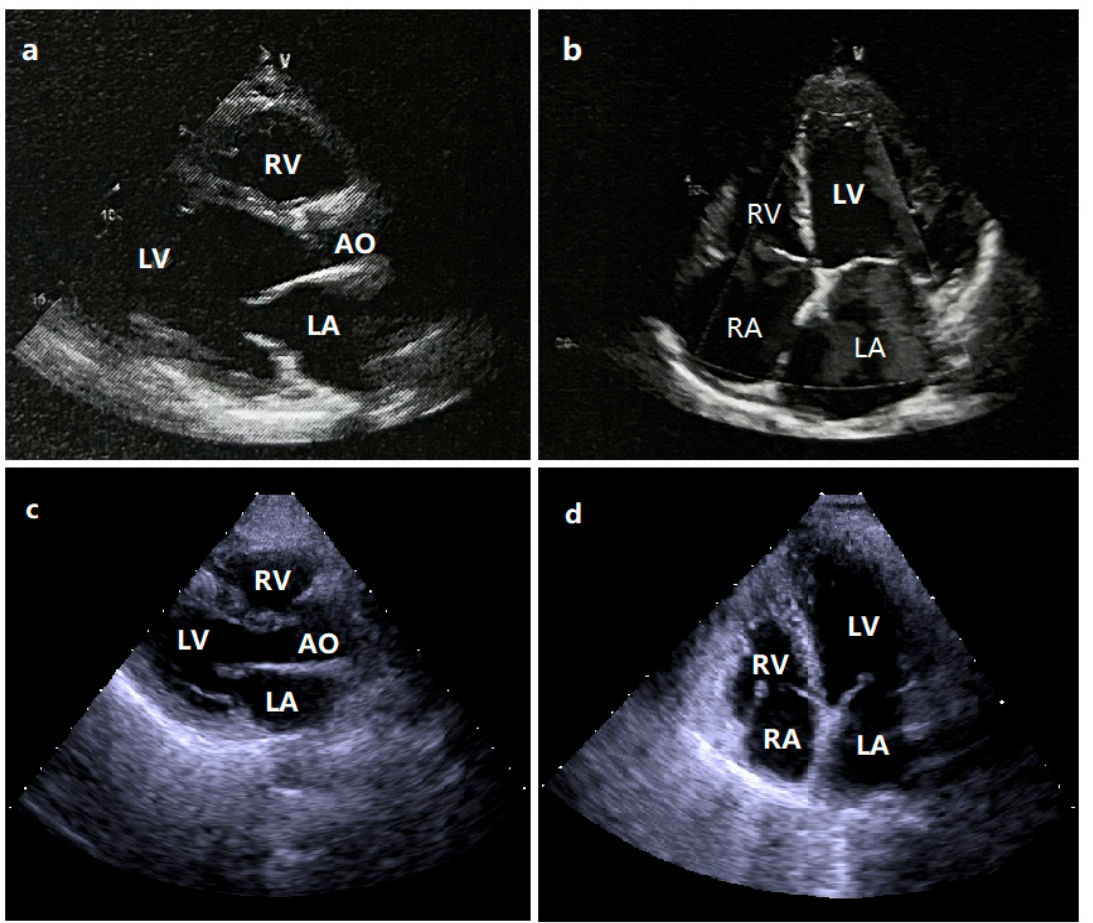
Figure 2. The representative transthoracic two-dimensional echocardiographic images from the proband affected with dilated cardiomyopathy and a healthy individual as a control: ( a ) transthoracic echocardiography findings at the left ventricular longitudinal view from the proband; ( b ) transthoracic echocardiography findings at the apical four-chamber view from the proband; ( c ) transthoracic echocardiography findings at the left ventricular longitudinal view from the control; ( d ) transthoracic echocardiography findings at the apical four-chamber view from the control. The echocardiographic images denote severe left ventricular dilation and systolic dysfunction. LV, left ventricle; RV, right ventricle; LA, left atrium; RA, right atrium; AO, aorta.